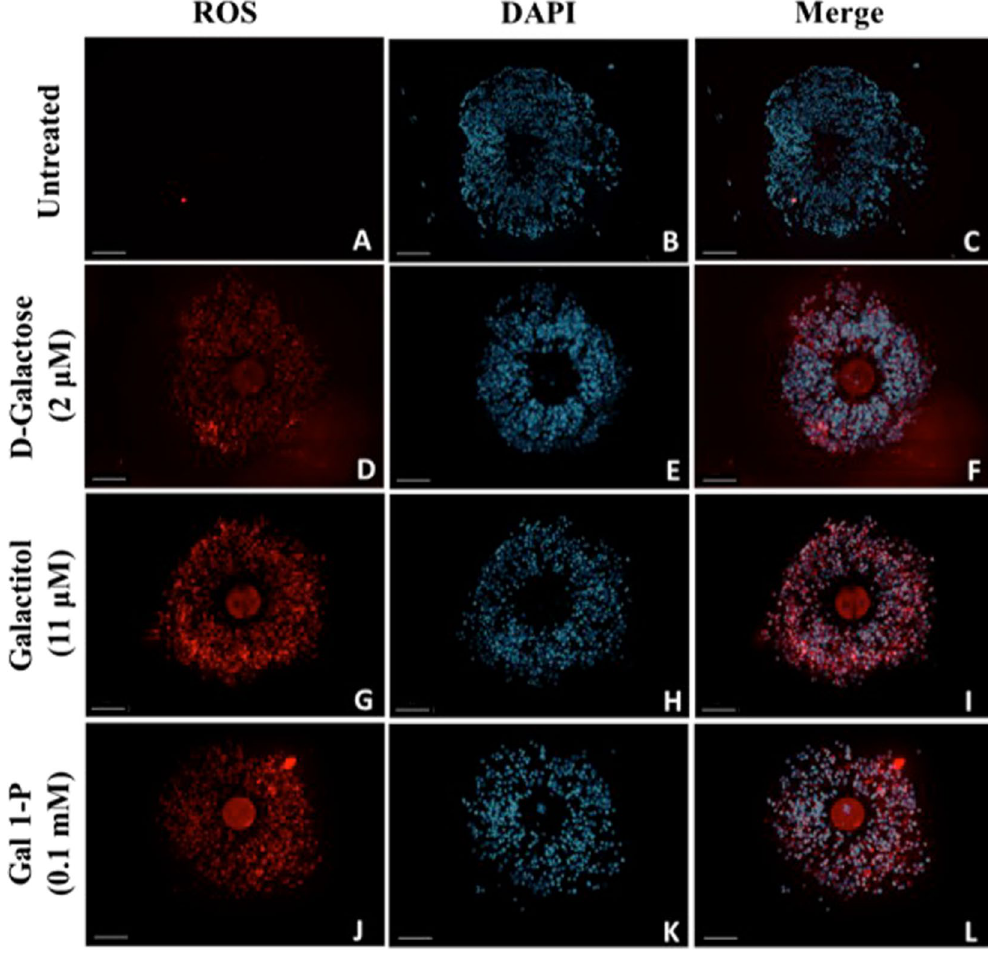
Figure 6. Evaluation of ROS generation. Images ( A – L ) represent images of intracellular ROS generation, 4 ′ ,6-diamidino-2-phenylindole (DAPI) fluorescence and merged images of ROS generation and DAPI of cumulus oocyte complex exposed to D-galactose (Images D – F ), galactitol (Images G – I ), and Gal 1-P (galactose 1-phosphate) (Images J – L ), and untreated control (Images A – C ). Scale bars: 100 μ m. Images shown are from a typical experiment performed at least three